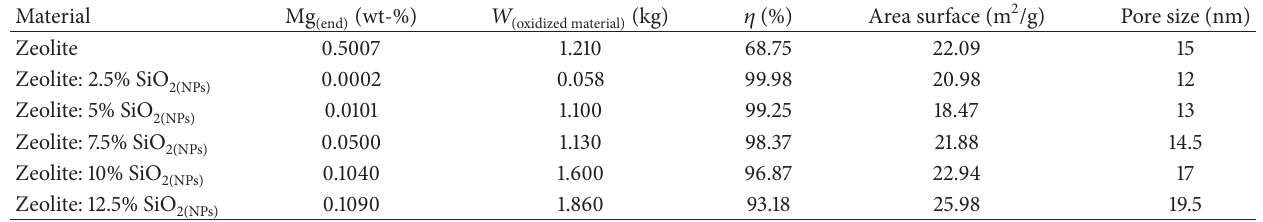
Table 2: Measurements of surface area of zeolite without and with amorphous SiO